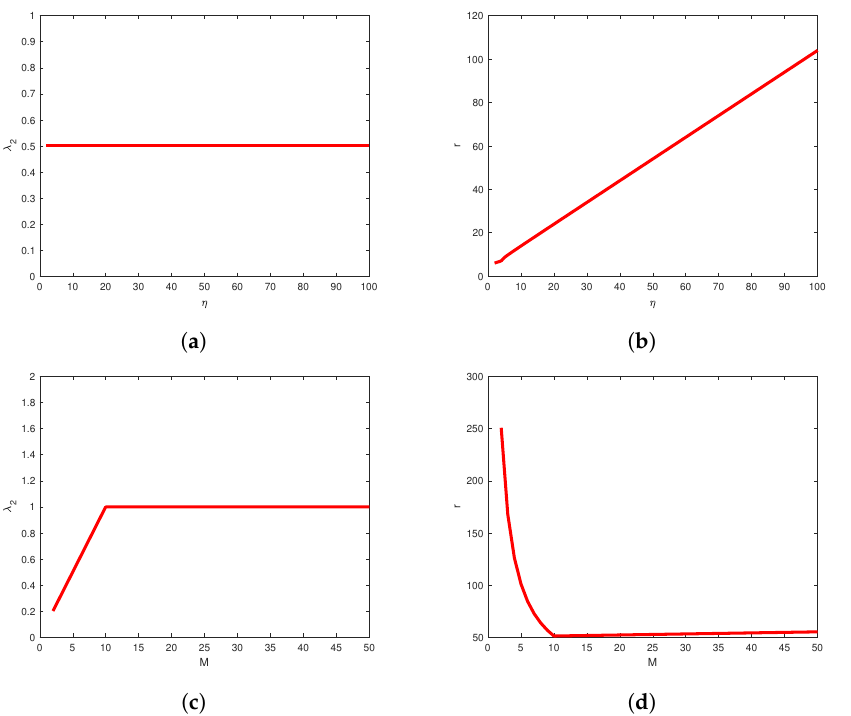
Figure 7. The synchronizability of Networks-B. Panel ( a ) depicts λ 2 vs. η and ( b ) depicts r vs. η when a = 0.5, d = 1, M = 2; Panel ( c ) depicts λ 2 vs. M and ( d ) depicts r vs. M when a = 1, d = 0.1, η = 50.